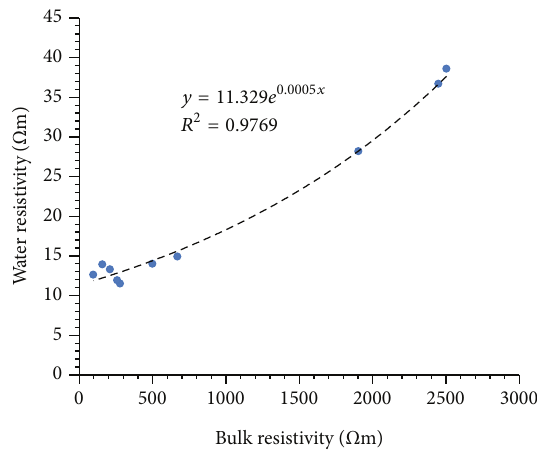
Figure 9: A graph of second layer water resistivity against bulk resistivity.